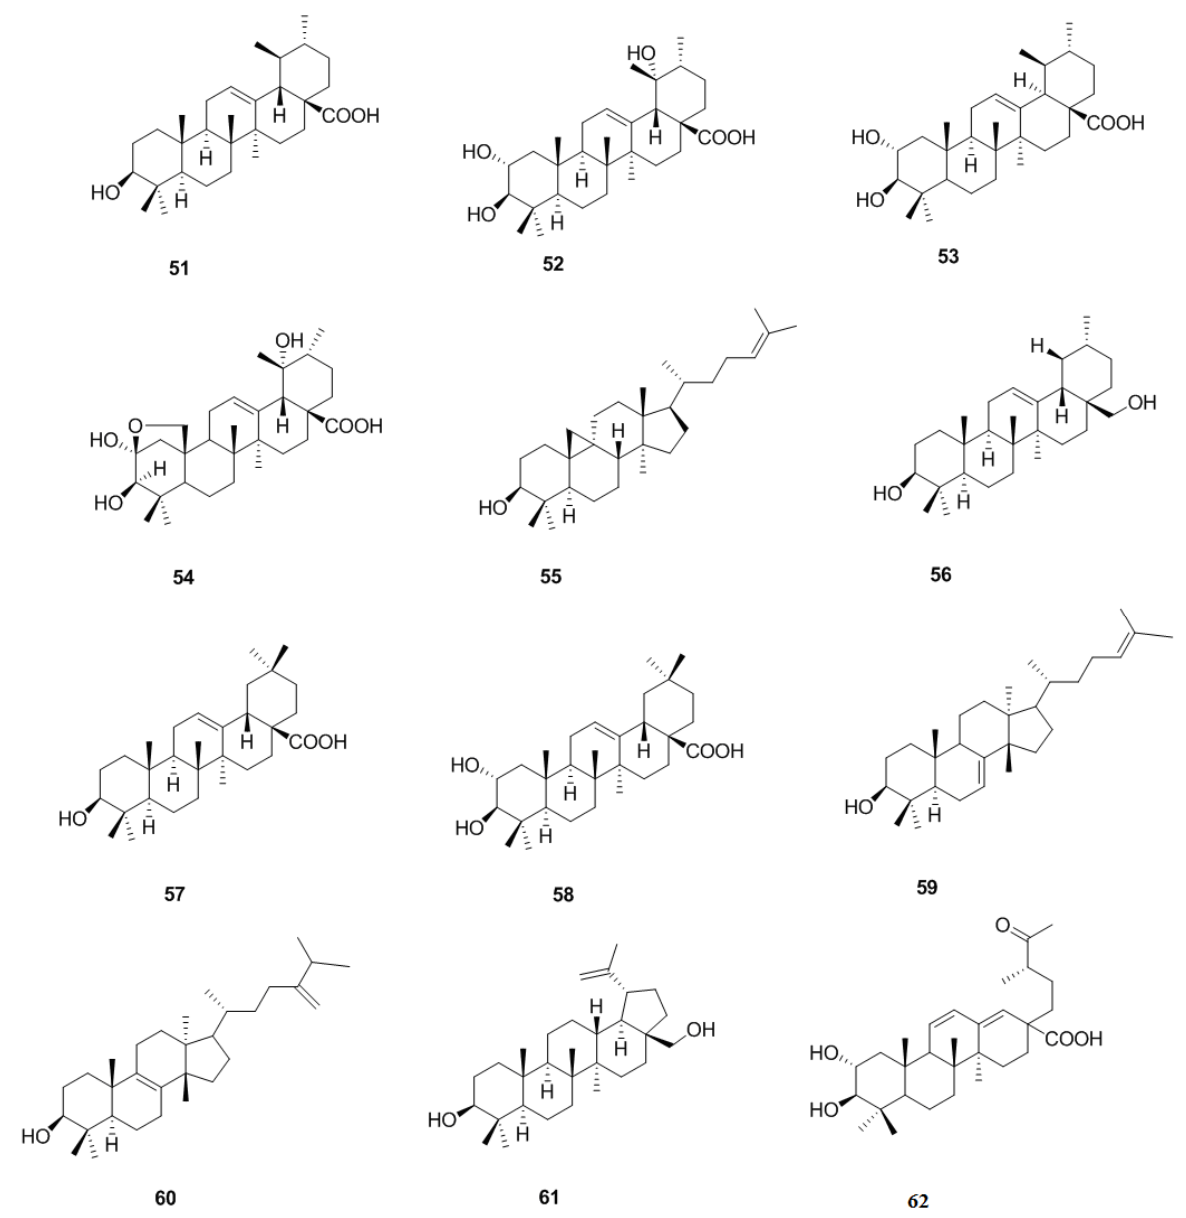
Figure 5. Chemical structures of triterpenoids in C. pinnatifida